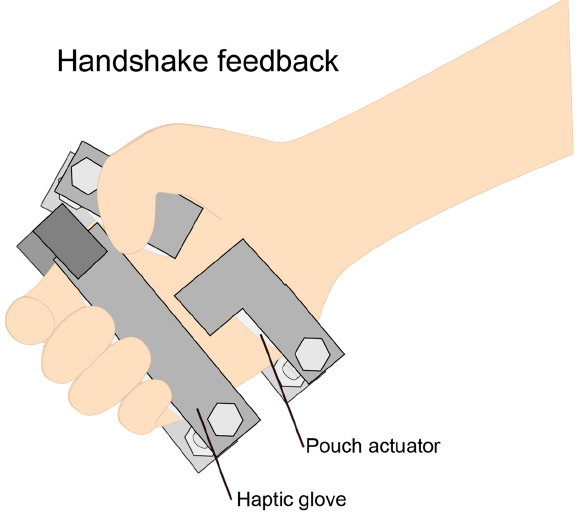
Figure 1. The haptic glove that simulates a handshake. The pouch actuators provide pressure onto the palm and the back of the hand to replicate the tactile perception in a handshake.